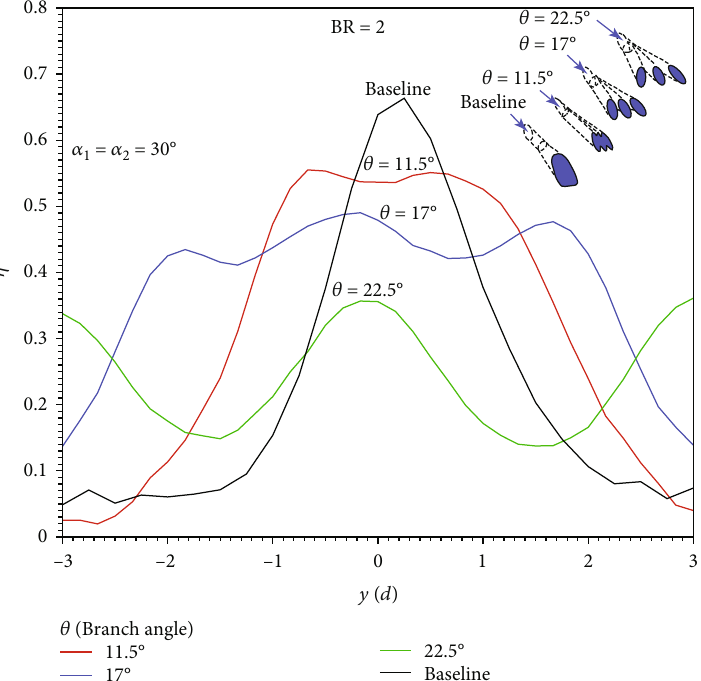
Figure 24: Spanwise (streamwise-averaged) fi lm e ff ectiveness variations at x / d = 5 for α ratio of BR = 2 .